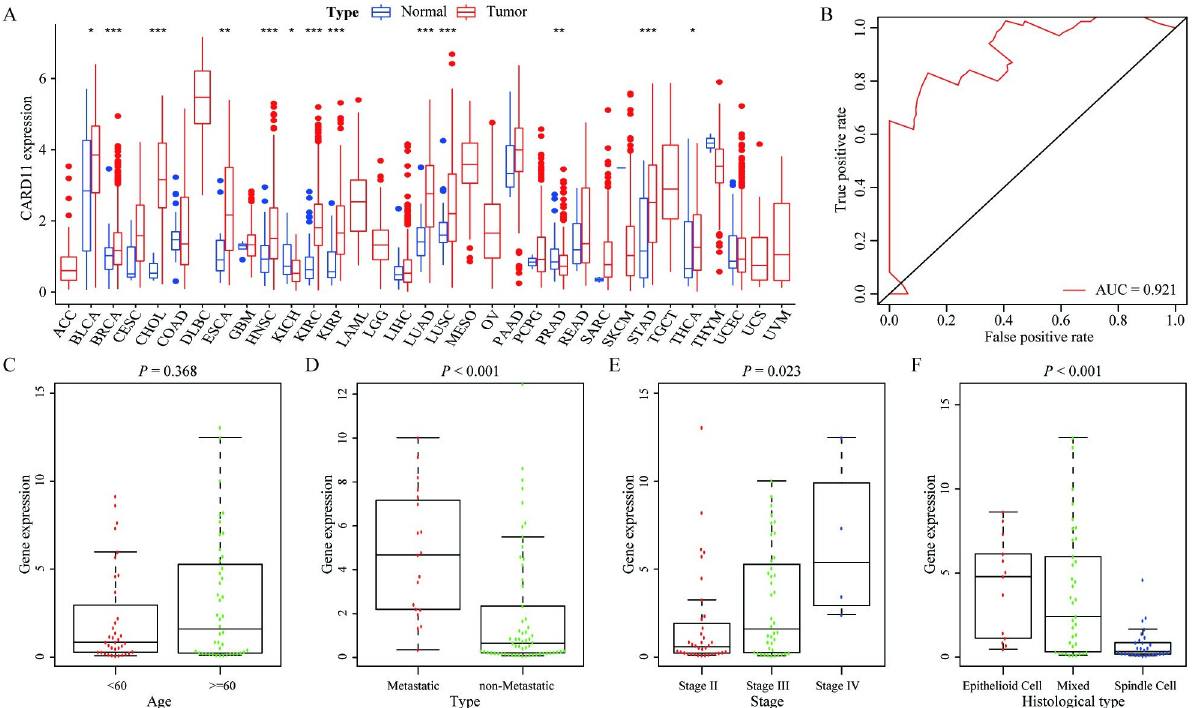
Fig 1. Correlation analysis between CARD11 expression and clinicopathological characteristics. ( A ) Expression of CARD11 in 33 types of tumors and their adjacent tissues in TCGA database; ( B ) ROC curve analysis of the accuracy of CARD11 in predicting the prognosis of patients; ( C-F ) Correlation between CARD11 expression and clinicopathological characteristics, in which CARD11 have no significant correlation with age ( P = 0.83; C ), but have significant correlation with a higher likelihood of metastasis ( P < 0.001; D ), higher grade clinical stage ( P = 0.023; E ), and tissue cell typing ( P < 0.001; F